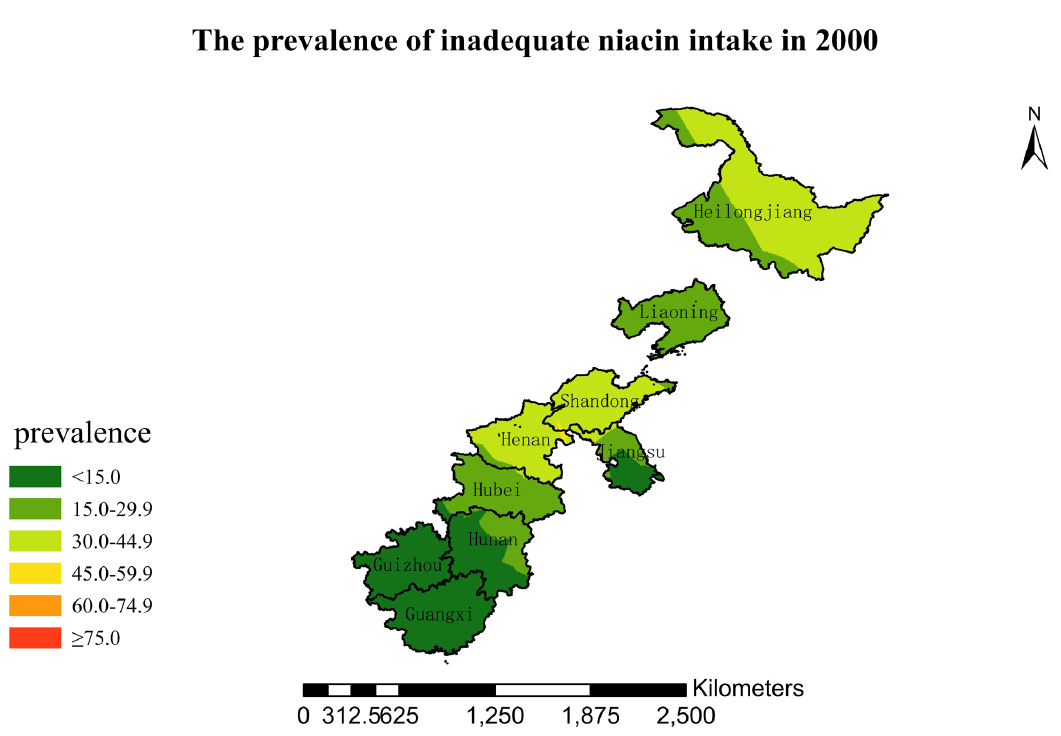
Figure 4. The prevalence of inadequate niacin intake by county in 2000 among Chinese Residents ≥ 5 Years of Age.